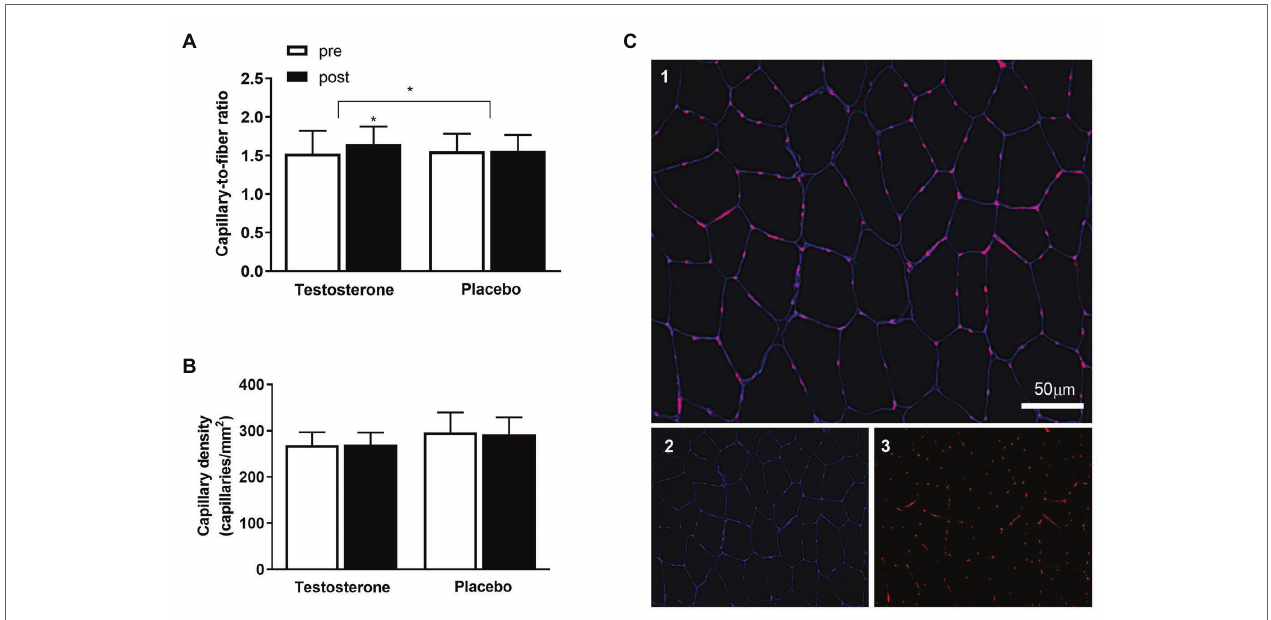
FIGURE 1 | The (A) displays the capillary-to-fiber (C/F) ratio and (B) the capillary density pre (white bars) to post intervention (black bars) in the testosterone ( n = 18) and placebo ( n = 15) groups. Data are presented as means ± SD. The (C) displays the immunohistochemical labeling of capillaries in the muscle cross-section. Merged image of CD31 in red and laminin in blue (C1) , single channel laminin in blue (C2) , and single channel CD31 in red (C3) . The white scale bar = 50 μ m. * = p < 0.05. The between-group differences in the changes from pre to post intervention with the baseline measurement as a covariate are indicated with the bracket and the * symbol. The * symbol over the bar indicates a within-group difference from pre to post